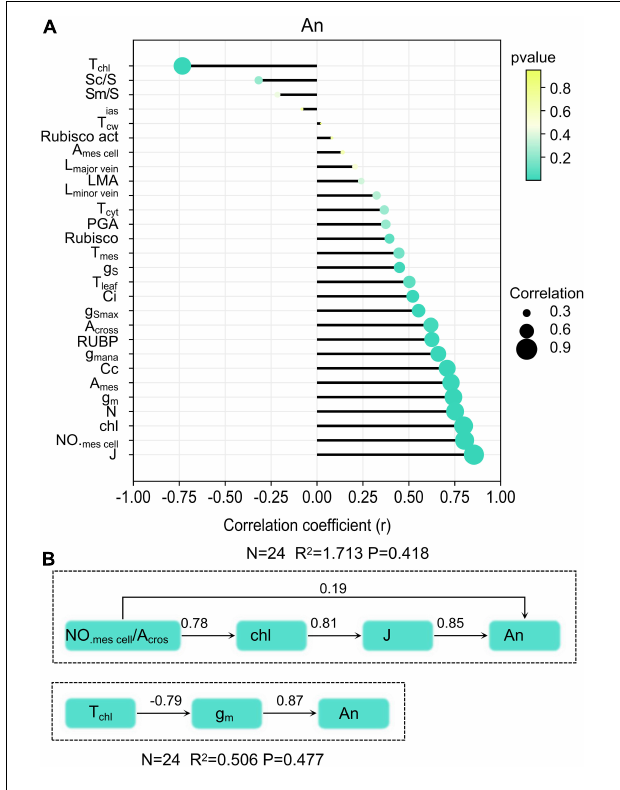
FIGURE 6 | Relationship between leaf traits and An (A) , and the structural equation model of leaf anatomy on An (B)